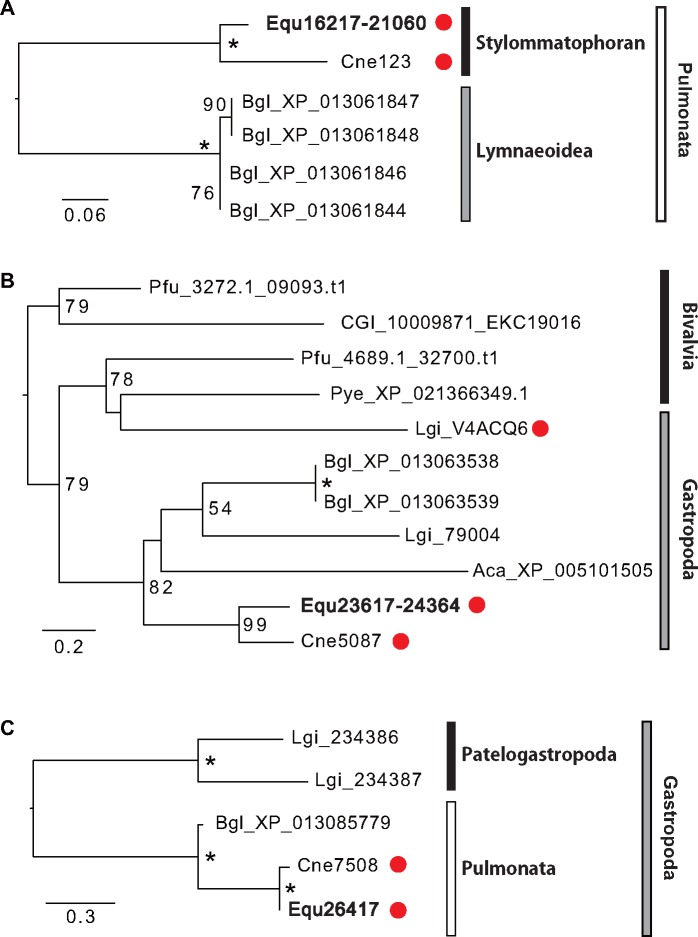
—Phylogeny of the most abundant SMPs identified from Euhadra quaesita. Three of the most abundant SMPs were identified by the abundance index values from LC-MS/MS analysis (fig. 3B). (A) The maximum likelihood tree was inferred from Equ16217–21060 and five genes that were found by BLASTX search against the GenBank database under the rtREV model (using 152 positions). (B) The maximum likelihood tree was inferred from Equ23617–24364 and ten genes that were found by BLASTX search against the GenBank database under the WAG  +  Γ model (using 332 positions). (C) The phylogenetic tree was inferred from Equ26417 and four genes that were found by BLASTX search against the GenBank database under the LG  +  Γ model (using 241 positions). All phylogenic analyses were performed with 100 bootstrap replicates, and bootstrap support values <50% are not shown. Asterisks indicate 100% bootstrap support. Branch lengths are proportional to the expected number of substitutions per site, as indicated by the scale bar. Red circles indicate proteins that have been identified as SMPs in this or previous studies. Aca, Aplysia california; Bgl, Biomphalaria glabrata; CGI, Crassostrea gigas; Cne, Cepaea nemoralis; Equ, Euhadra quaesita; Lgi, Lottia gigantea; Pye, Patinopecten yessoensis; Pfu, Pinctada fucata.